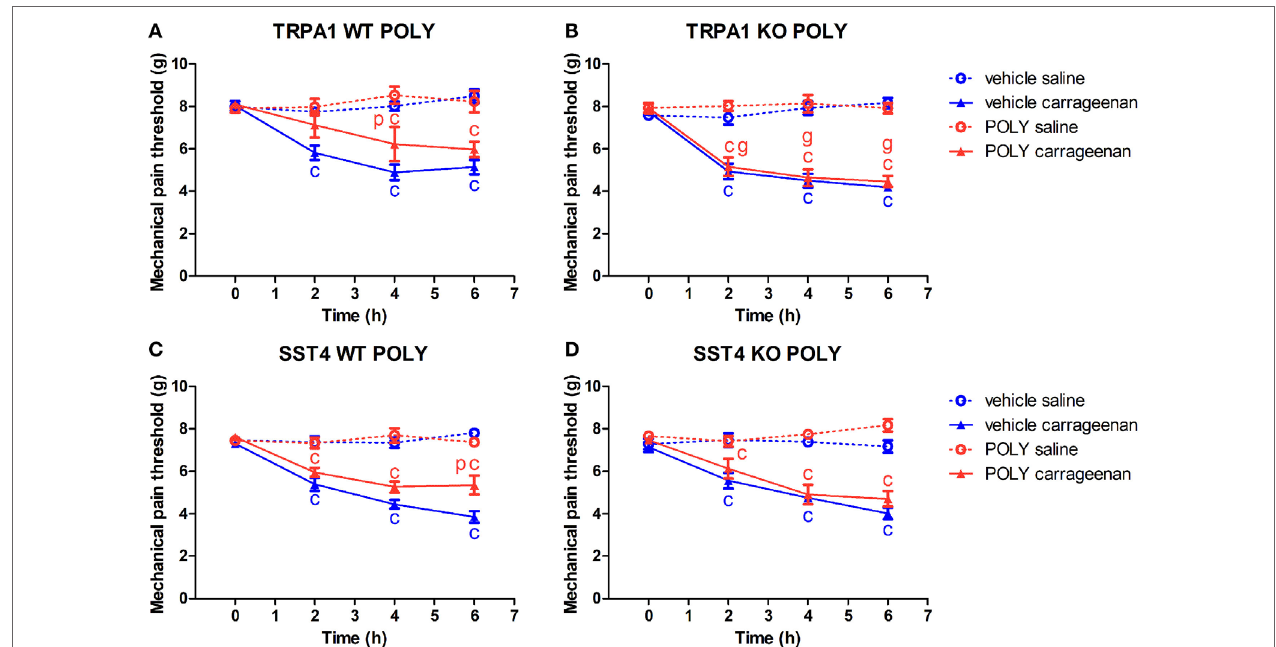
FigUre 1 | Antinociceptive effect of sodium polysulfide (POLY, 17 µmol/kg) in carrageenan-induced paw inflammation is mediated by transient receptor potential ankyrin 1 (TRPA1) and sst4 receptors. Mechanical pain threshold of saline or carrageenan-injected (3% in 20 µL saline) hind paws of (a) TRPA1 WT, (B) TRPA1 KO, (c) sst4 receptor WT, and (D) sst4 receptor KO animals in response to POLY or vehicle treatment. Data are shown as mean ± SEM. n = 6–8. c p < 0.05 vs. saline-injected paws. p p < 0.05 vs. vehicle of POLY. g p < 0.05 vs. TRPA1 WT animals. Two-way repeated-measure ANOVA followed by Bonferroni’s multiple comparison